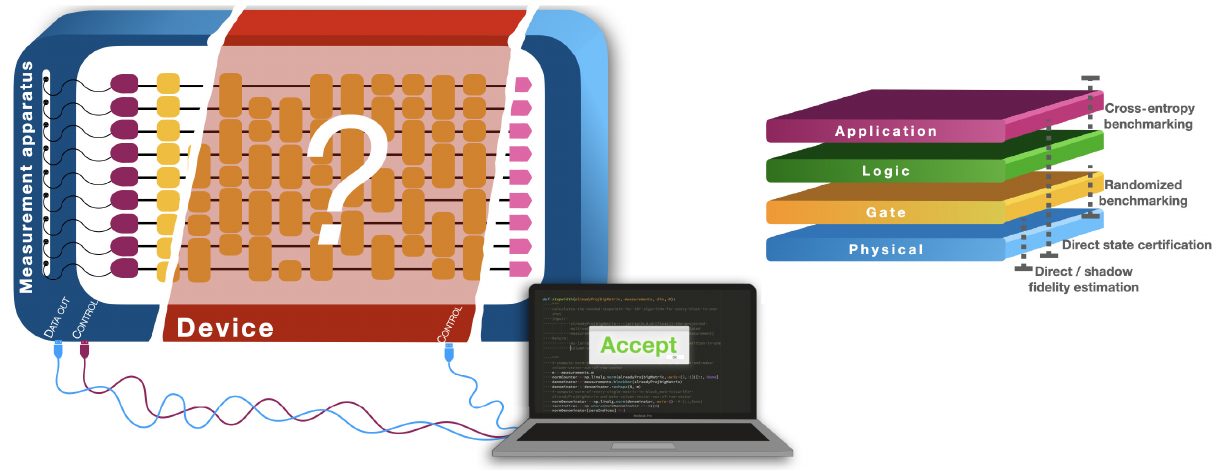
FIG. 1. Left: the theoretical description of protocols makes use of the distinction into the device, measurement apparatus, and classical processor. Right: a complex quantum device comprises multiple abstraction layers. Different protocols aim at certifying the functioning of the device on different layers. NISQ devices are not expected to feature a powerful logical-gate layer. Instead, applications are directly tailored to the physical-gate